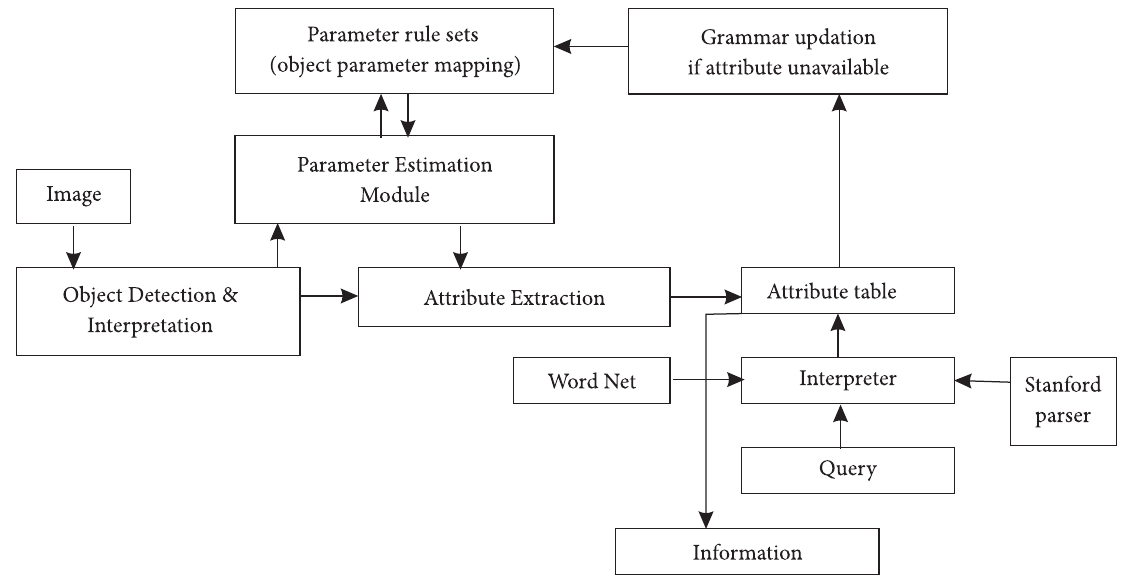
Fig. 1. Methodology